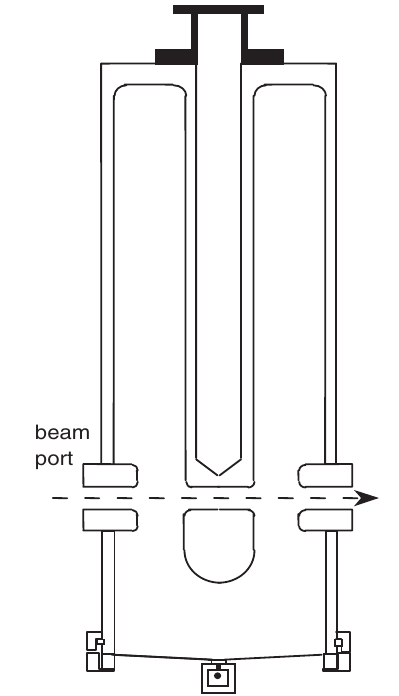
FIG. 9. A mechanical outline of the 80 MHz QWR at LNL,